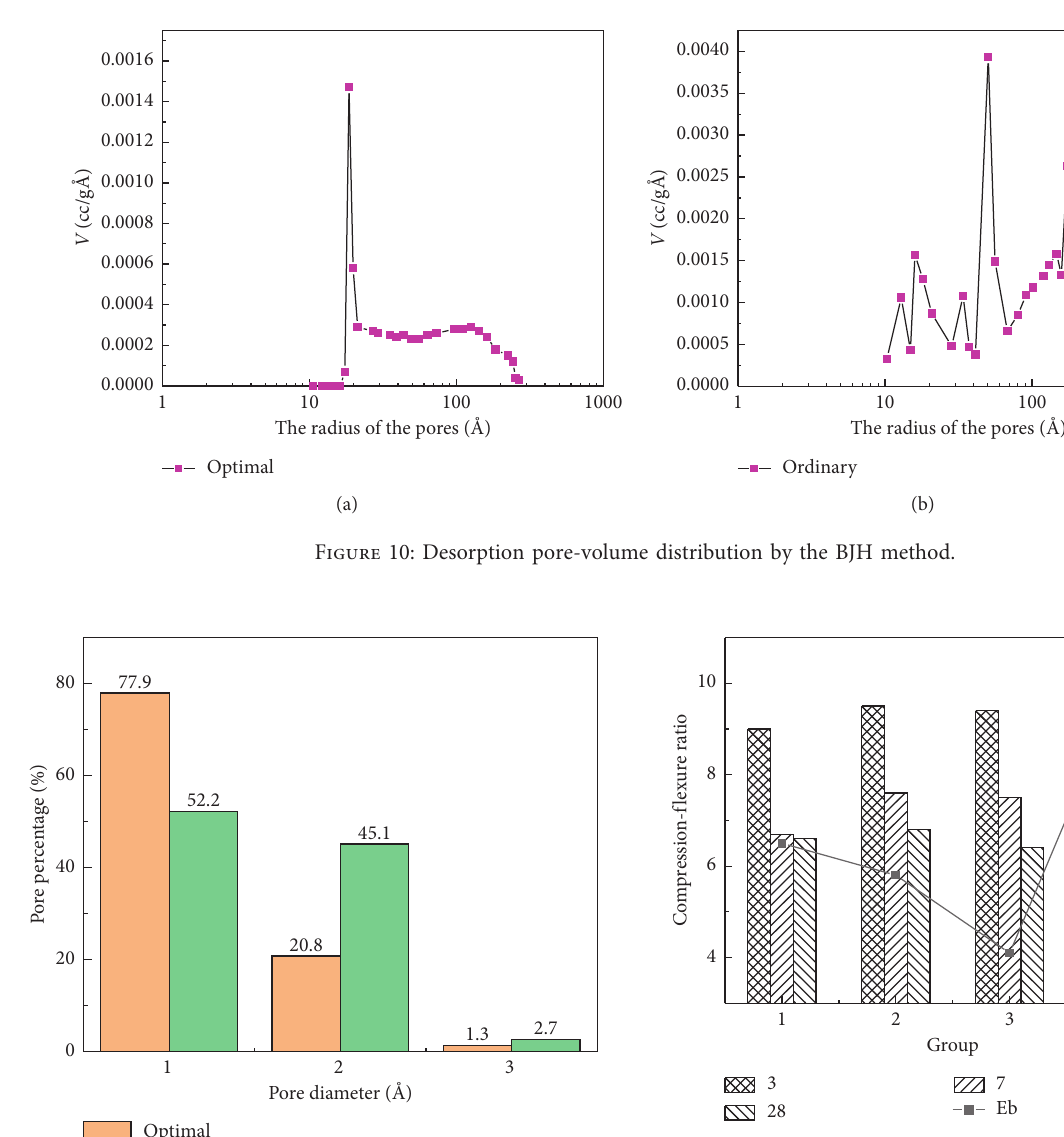
Figure 12: The brittle property of optimized pavement concrete.